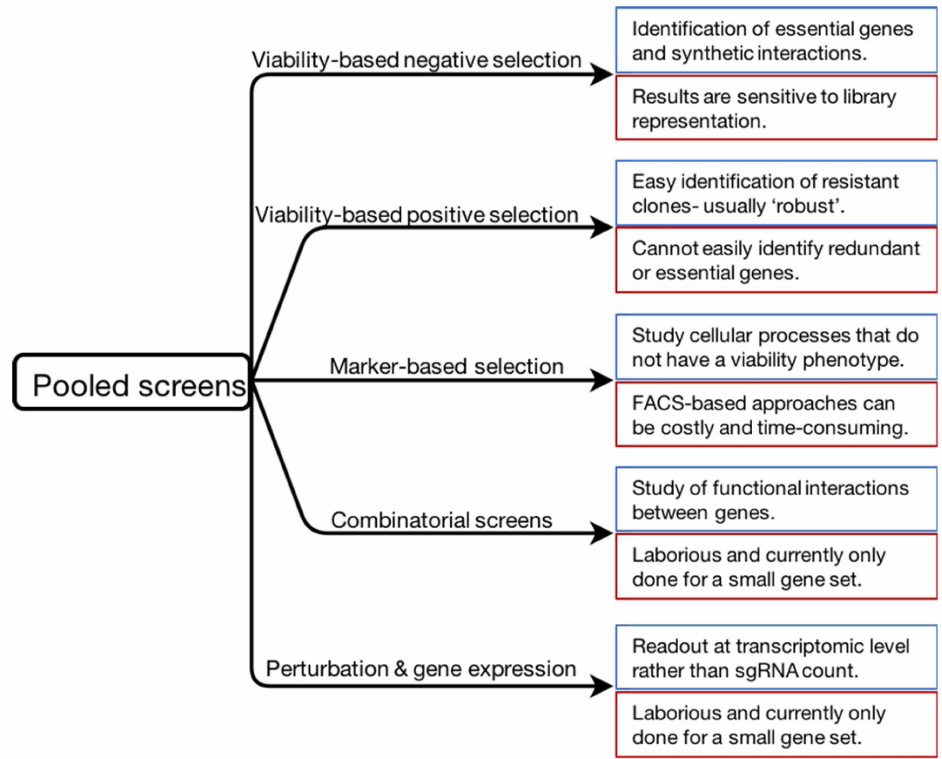
Figure 2. Summary of the screening approaches described in this review. Specific features of each approach are indicated in blue (strengths) and red (limitations)